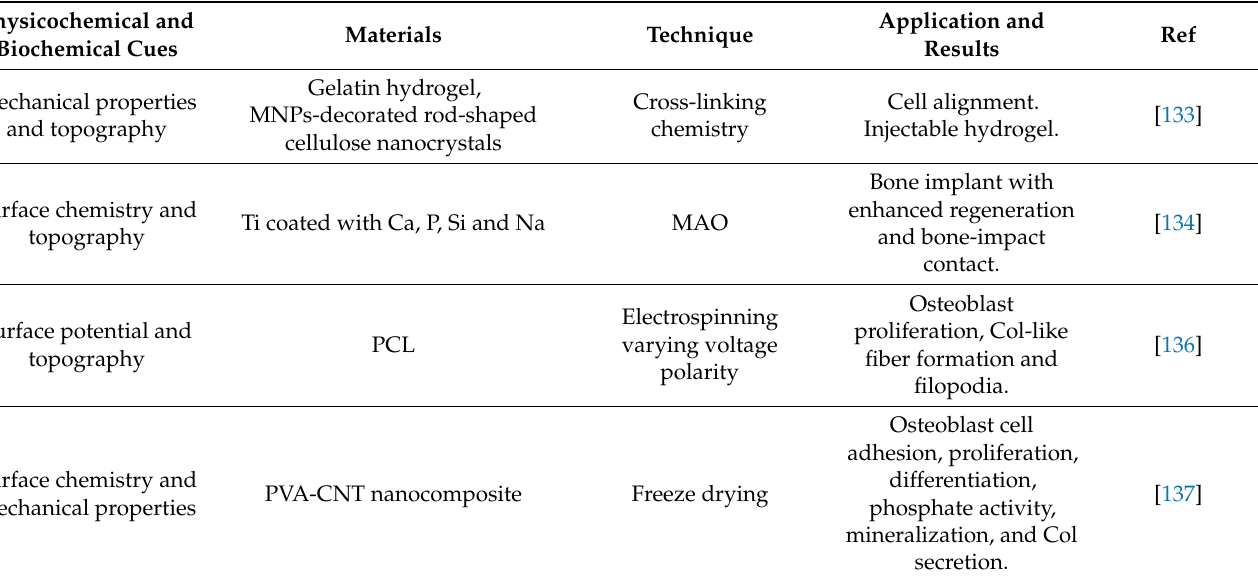
Table A2. Summary of multifunctional scaffolds for tissue engineering reviewed in this